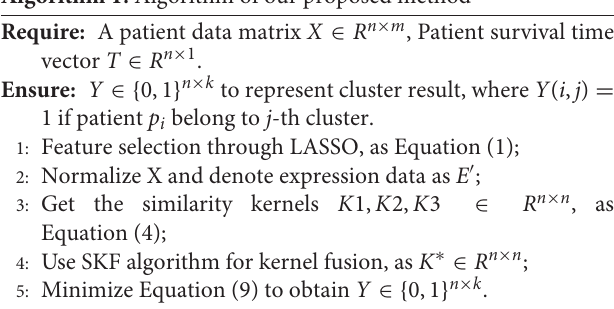
Algorithm 1: Algorithm of our proposed method